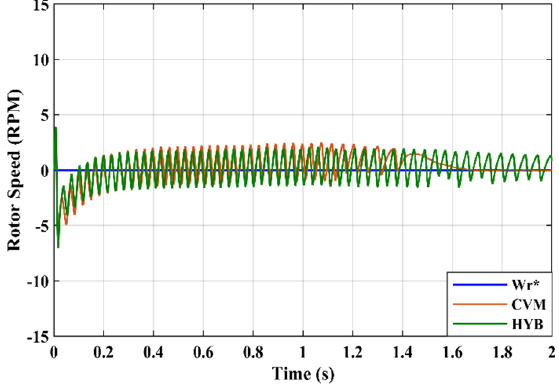
Figure 18. Rotor speed response at zero speed condition.